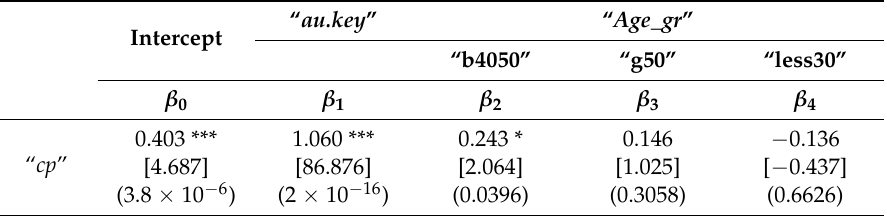
Table A4. Estimation results of “ cp ” against “ age_gr ” and “ au.key ”.